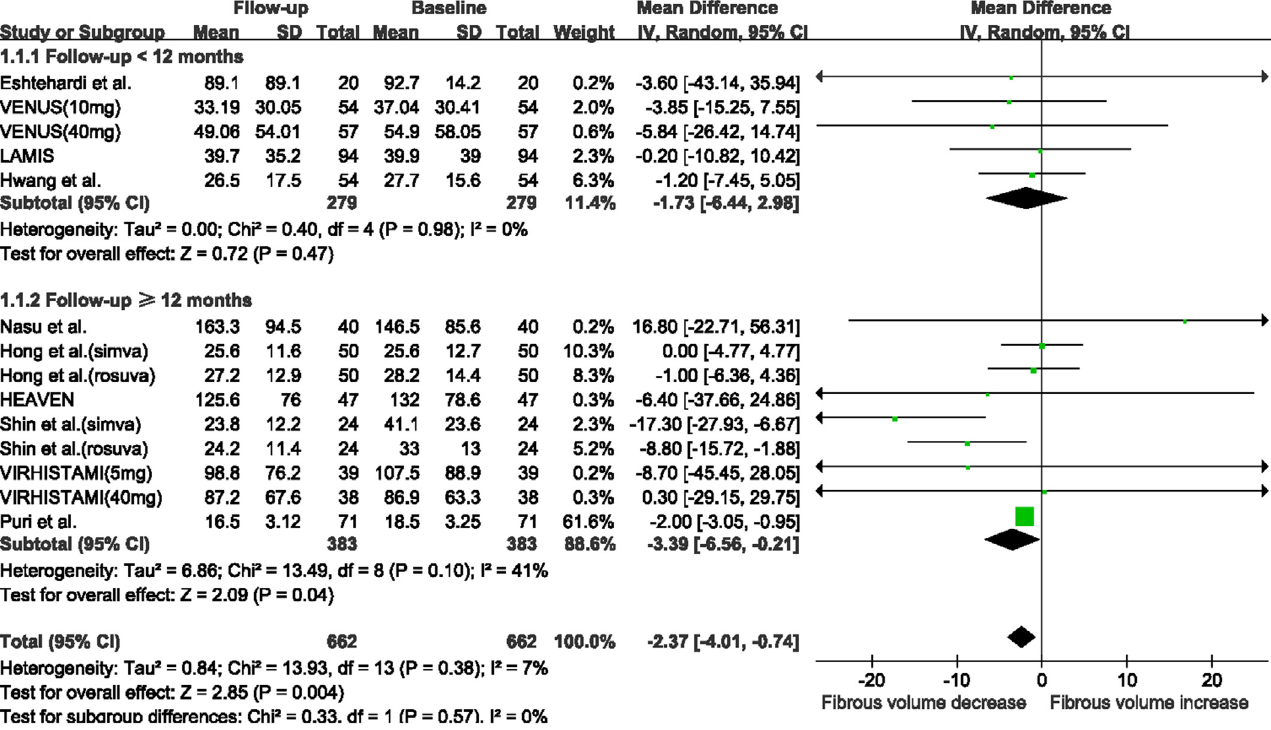
Fig 4. Meta-analysis of changes in fibrous volume with statin therapy using stratified analysis based on follow-up duration. Abbreviations: CI: confidence interval; SD: standard deviation.